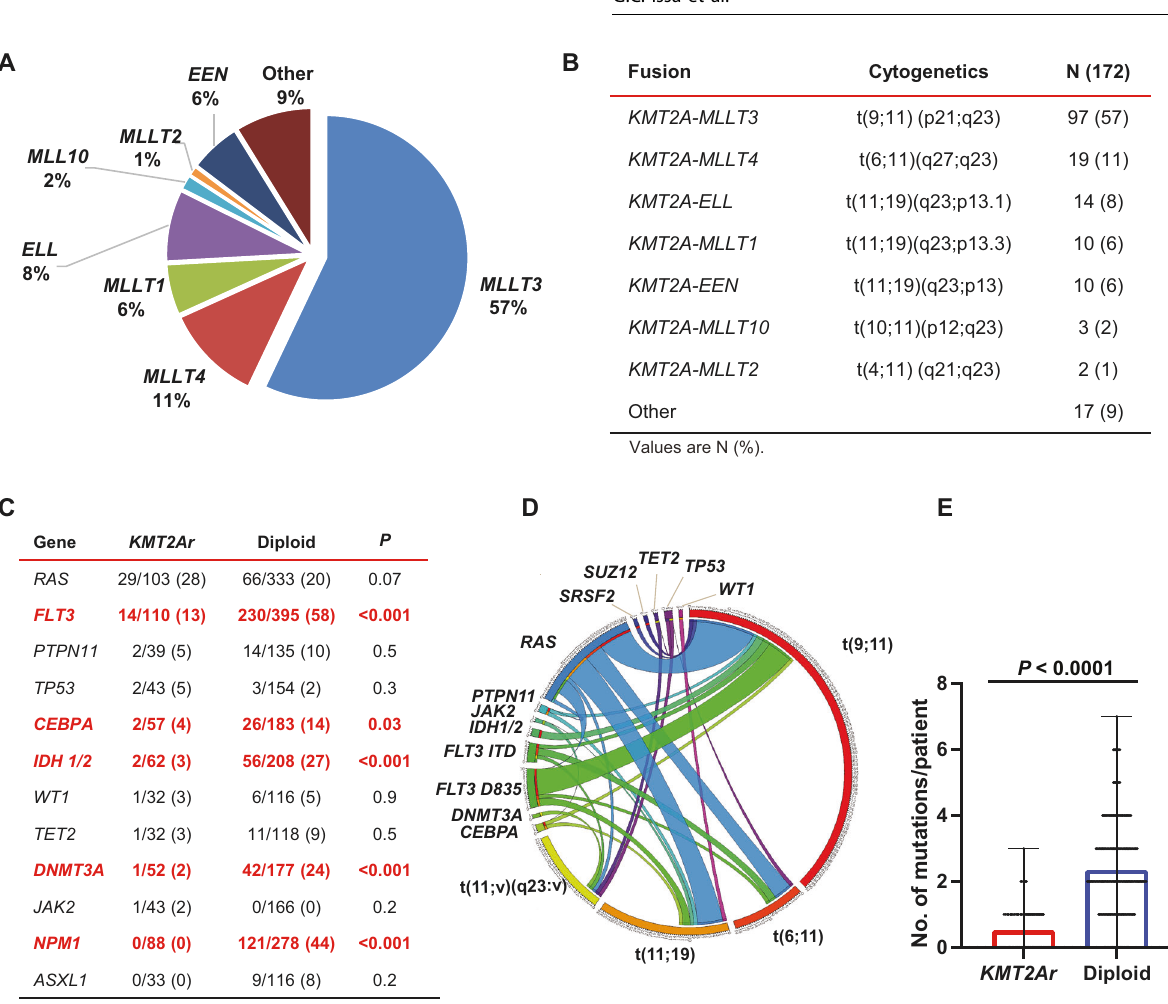
Fig. 1 Fusion partner genes and mutational pro fi le of adults with newly diagnosed KMT2Ar AML. A Distribution of fusion partner genes. B Cytogenetics and distribution of 11q23 translocations. C Genes most commonly mutated in KMT2Ar AML compared to an age-matched cohort of AML with a diploid karyotype. D Circos plot depicting patterns of co-occurrence between mutations and various translocations leading to KMT2Ar . E Number of mutations per patient comparing KMT2Ar AML to an age-matched cohort of AML with a diploid